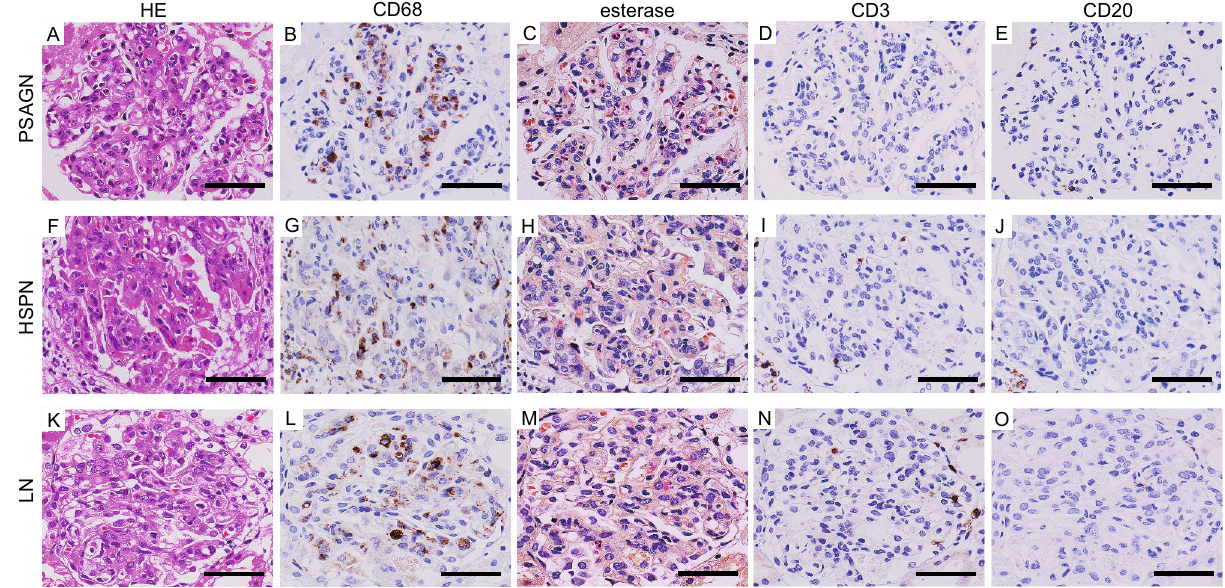
Figure 5. Characteristics of infiltrating cells in GN with EP lesions. Representative images of PSAGN ( A – E ), HSPN ( F – J ), and LN ( K – O ). HE staining (panels A, F, and K) and immunostaining for CD68 (a pan- macrophage marker; B , G , L ), esterase (a neutrophil marker; C , H , M ), CD3 (a T lymphocyte marker; D , I , N ), and CD20 (a B-lymphocyte marker; E , J , O ). Scale bars, 50